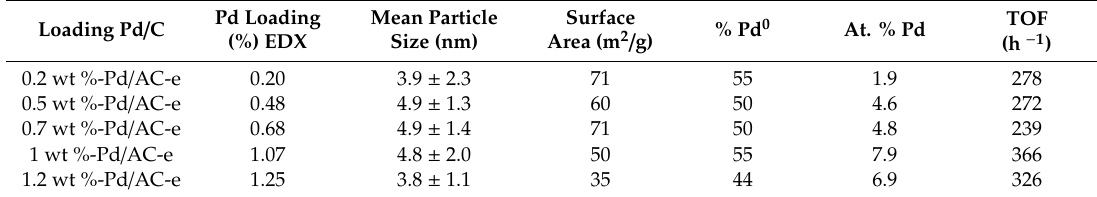
Figure 4. E ff ect of Pd sol preparation in the catalytic decomposition of formic acid as a function of the NaBH 4 / Pd molar ratio on AC and TiO 2 . Structural and chemical composition of the catalysts studied during e ff ect of loading